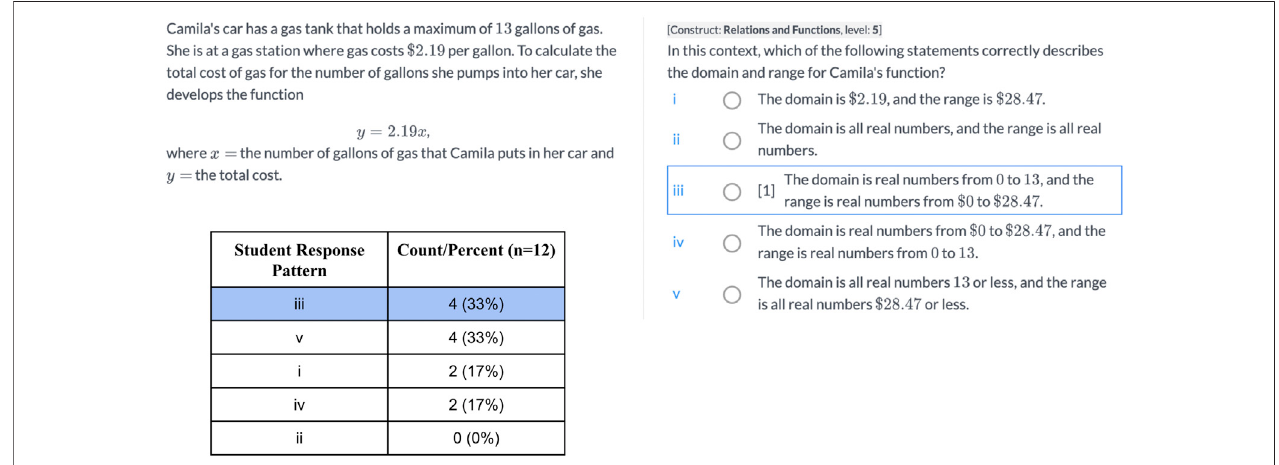
FIGURE 8 | Item 1818 aligned to Level 5 “ Given verbal descriptions of two-variable relations, graphs, or equations for linear functions, identi fi es their domain and range ” .